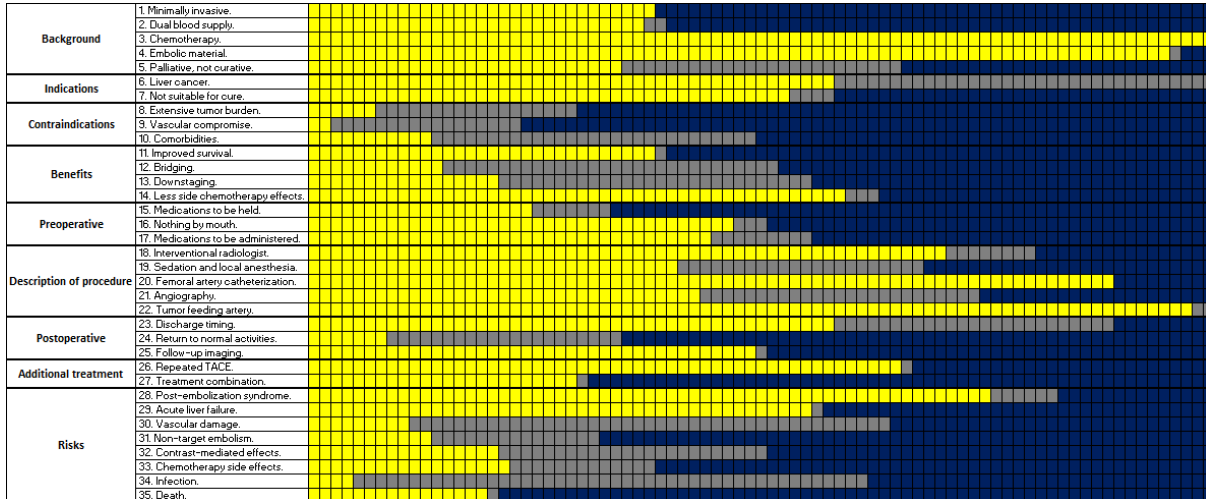
Figure 3. Distribution of scores on each component of the transarterial chemoembolization–content score. Scores range from 0 (no mention, blue) to 2 (full mention, yellow). TACE: transarterial